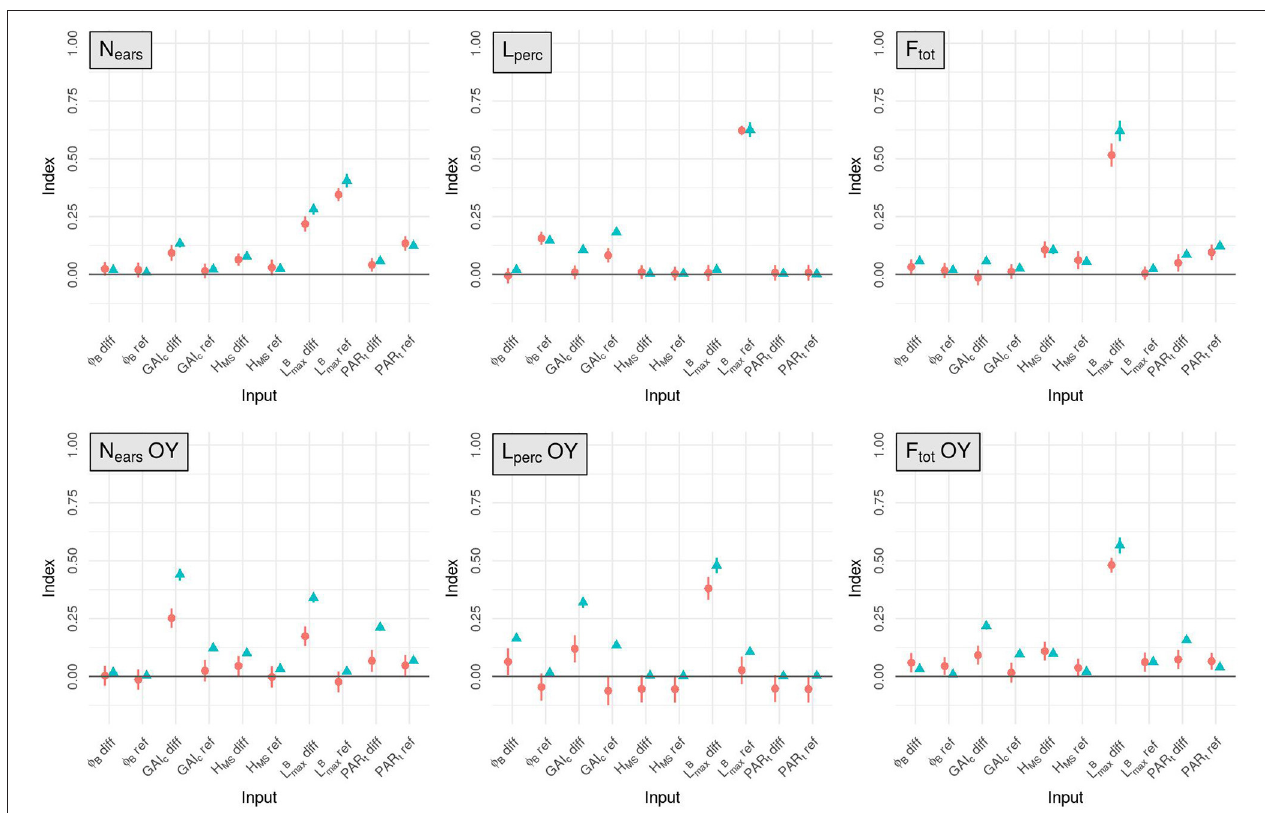
FIGURE 2 | Mean estimates for the total-order (blue triangles) and first-order (red circles) Sobol indices computed for N ears , L perc , F tot and the OY of these three outputs, for the 10 input factors (x-axis). The standard-deviation of each index is represented with a vertical